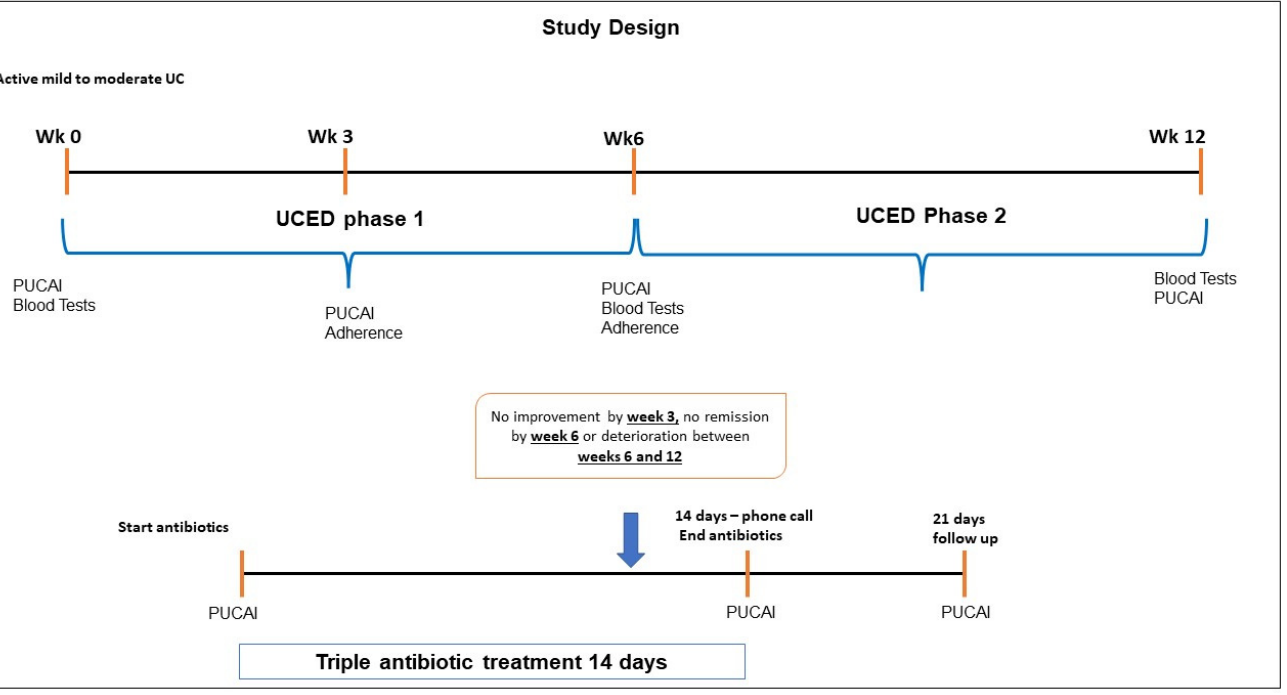
Figure 1. Trial Figure 1. Trial design.